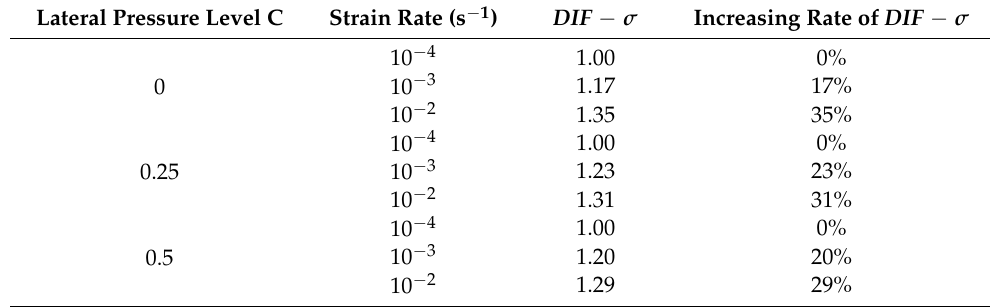
Table 6. Dynamic intensity growth factor ( DIF ) − σ values of ECC under different lateral pressure levels.